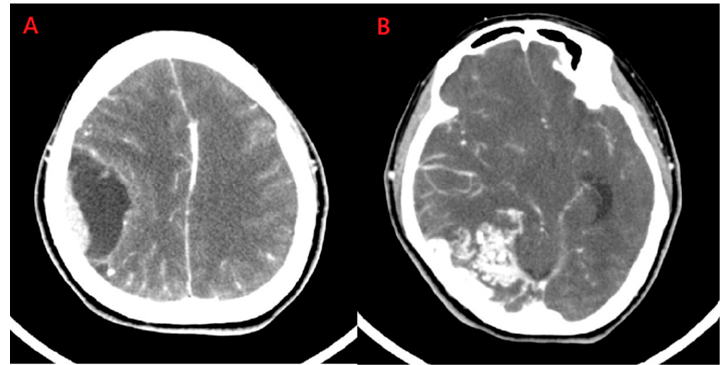
Figure 1. Computed tomography of brain. ( A ) The lesion with perifocal edema was seen in the right temporo-parietal area; ( B ) Another lesion with focal heterogeneous enhancement and a surrounding multilinear contrast structure with a lower density and calcified spots was noted in the right parieto- occipital region.